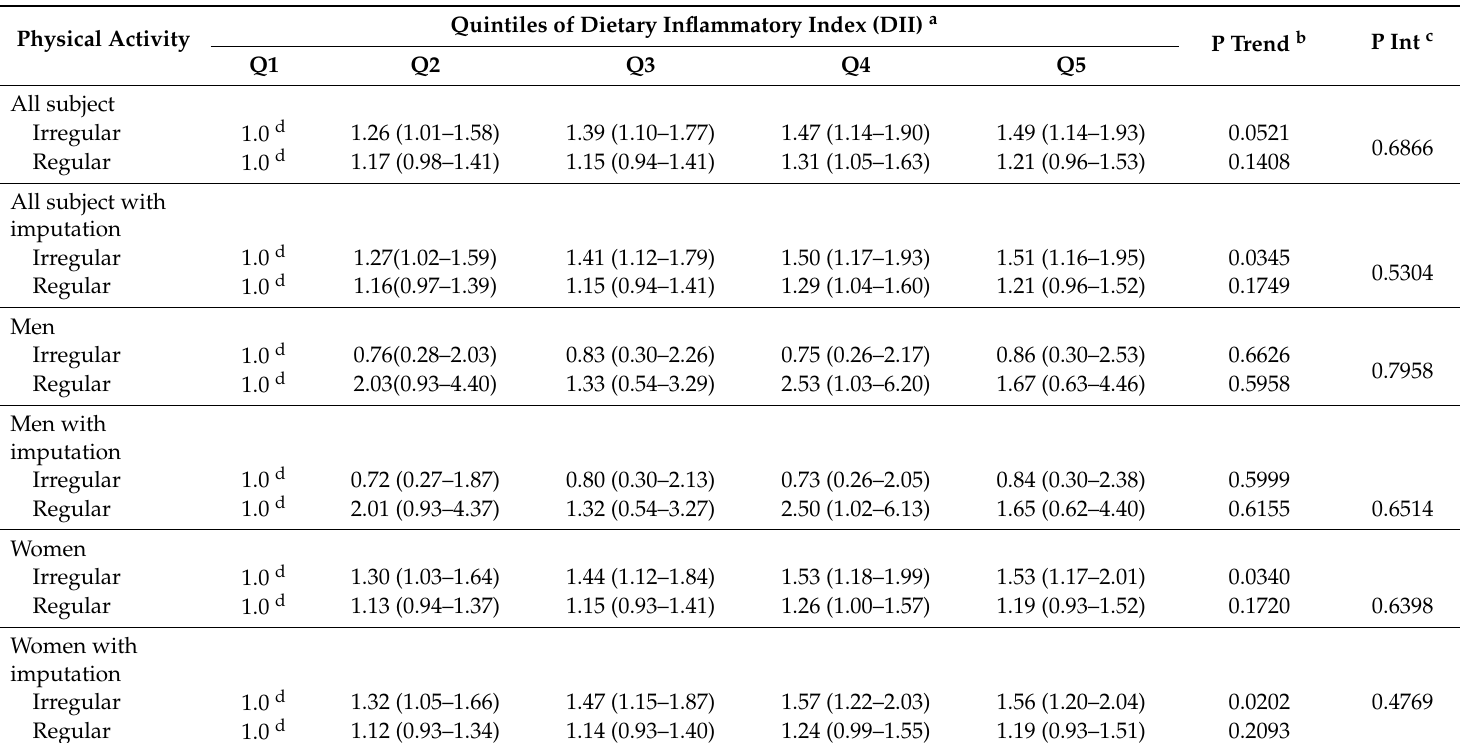
Table 4. Multivariate Cox Proportional Hazard Ratios (HRs) (95% Confidence Intervals (CIs)) for osteoporosis risk as stratified by physical activity regularity in the KOGES cohort,